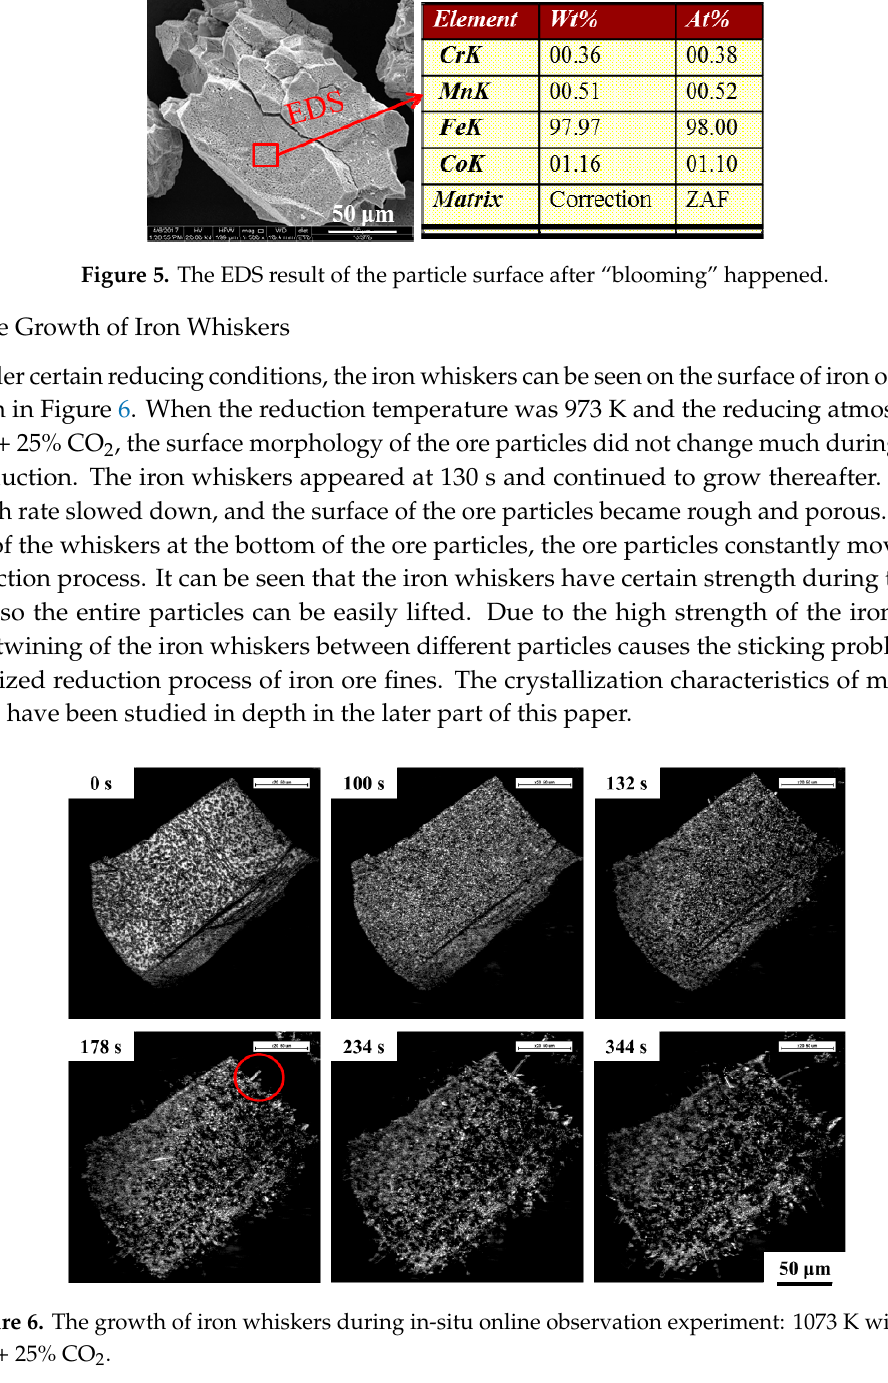
Figure 4. The “blooming” phenomenon during in-situ online observation experiment: 1073 K with 85% CO + 15% CO 2 .